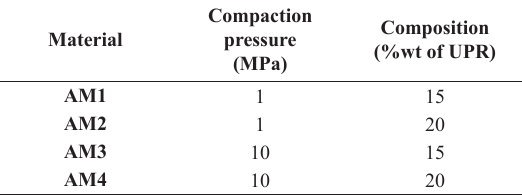
Table 1. Compaction pressure and composition of evaluated artificial